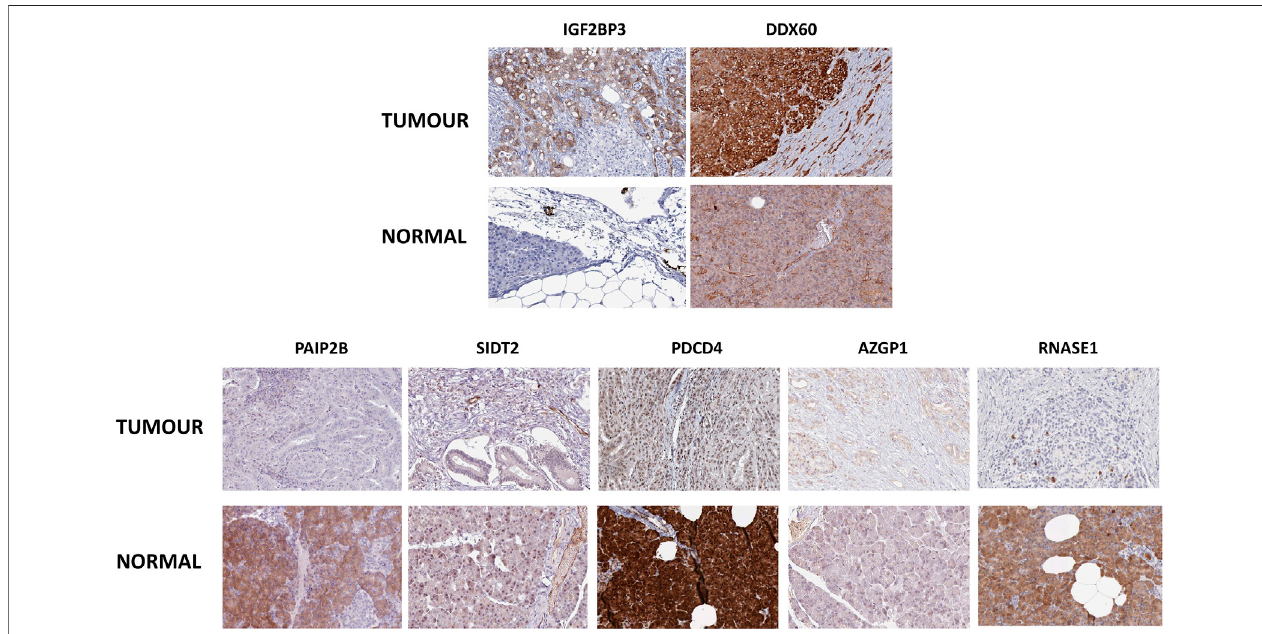
FIGURE 2 | Representative Immunohistochemistry images showing expression of top-altered DE-RBPs in respective pancreatic tissues from the Human Protein Atlas Database. Upper panel shows the images of top overexpressed DE-RBPs and the lower panel shows images of most underexpressed DE-RBPs.